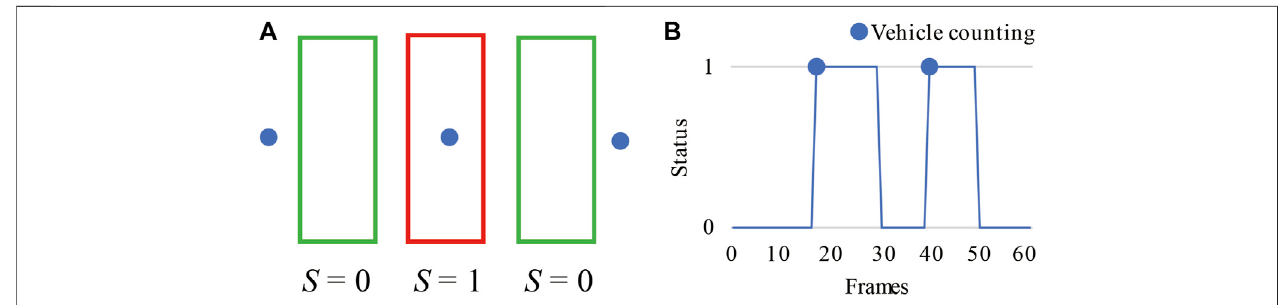
FIGURE2| Theprincipleofvehiclecountingbasedonvirtualdetectionareas. (A) Statuschangeofavirtualdetectionarea; (B) Flowcurveofavirtualdetectionarea.